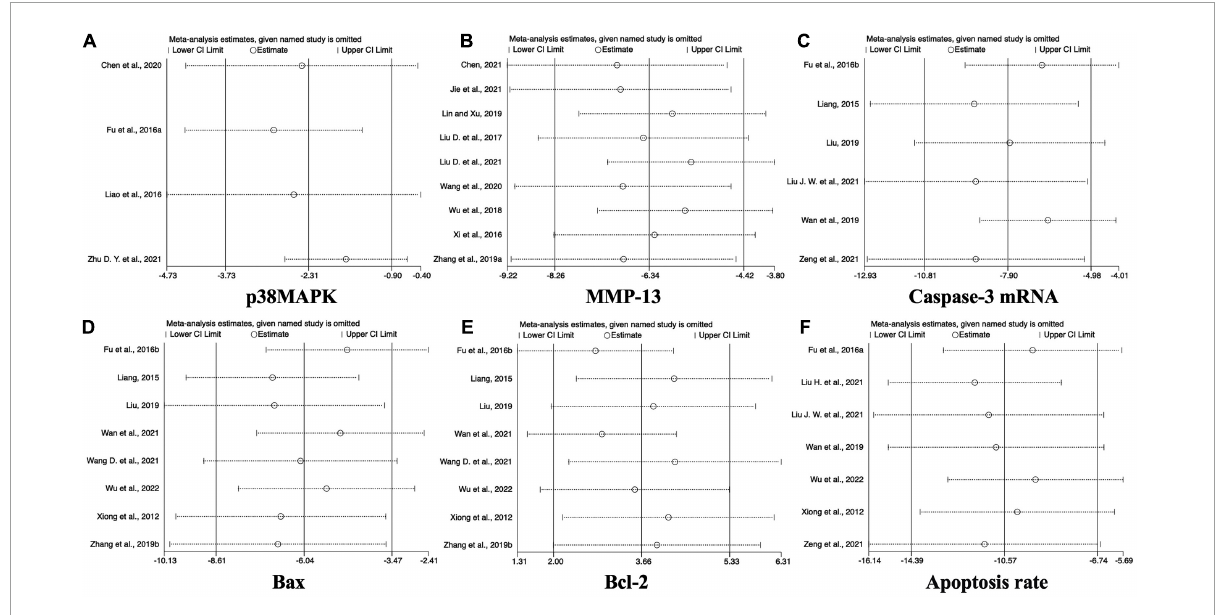
FIGURE8 Sensitivity analysis of acupuncture effects on p38MAPK, MMP-13, Caspase-3 mRNA, Bax, and Bcl-2 in KOA